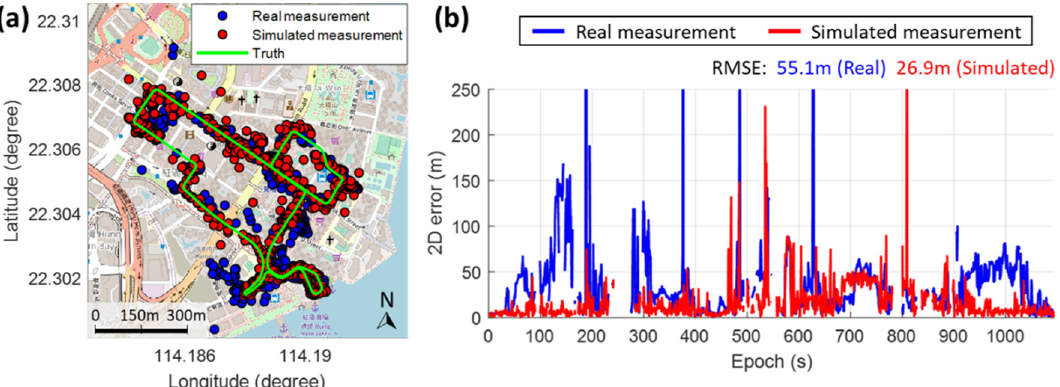
Figure 20. ( a ) The positioning solutions from real measurements (blue) and simulated measurements (red) during the dynamic experiment; ( b ) the corresponding least squares positioning 2D errors and the overall RMSE from the simulation and real measurements.